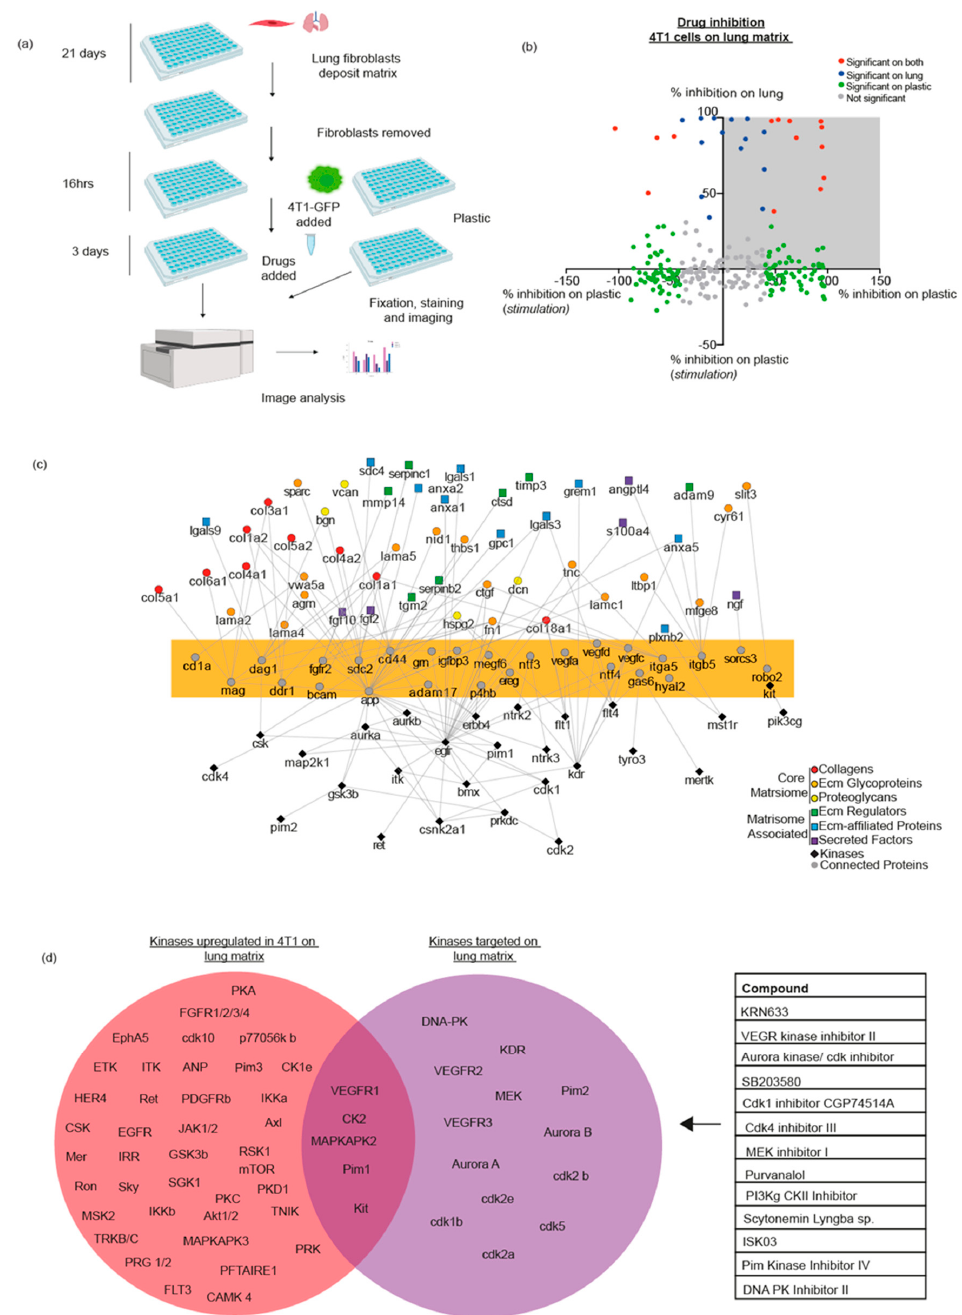
Figure 3. ( a ) Schematic showing the experimental workflow used for the kinase inhibitor drug screening on the lung FDM. Fibroblasts are treated to deposit ECM for 21 days, after which they are removed and 4T1-H2B-GFP cells are seeded. After 16 h, the drug library is added, and after 3 days, cells are fixed, stained, imaged, and analysed. ( b ) X/Y plot showing drugs that only inhibited cell growth on the lung matrix, plastic or on both. Colours represent statistical significance in inhibition ( p -value < 0.05) of 4T1 cells either on the lung FDM, plastic, or both substrates. ( c ) Network analysis linking the ECM proteins, which are enriched in the lung FDM with kinases which are up-regulated in 4T1s on the lung FDM vs. plastic. Physical protein–protein interactions are linked (grey circles) and proteins highlighted in yellow are receptors and proteins predicted to link the ECM and kinases. ( d ) Venn diagram; in the red sphere showing a list of kinases which are up-regulated in 4T1 cells on the lung FDM (both PTK and STK). Purple sphere contains the kinases which were successfully targeted on the lung matrix when the kinase inhibitor drug screen was performed. Overlap represents kinases that crossover. Table showing the drugs which significantly inhibited 4T1 cancer cell proliferation, specifically on the lung